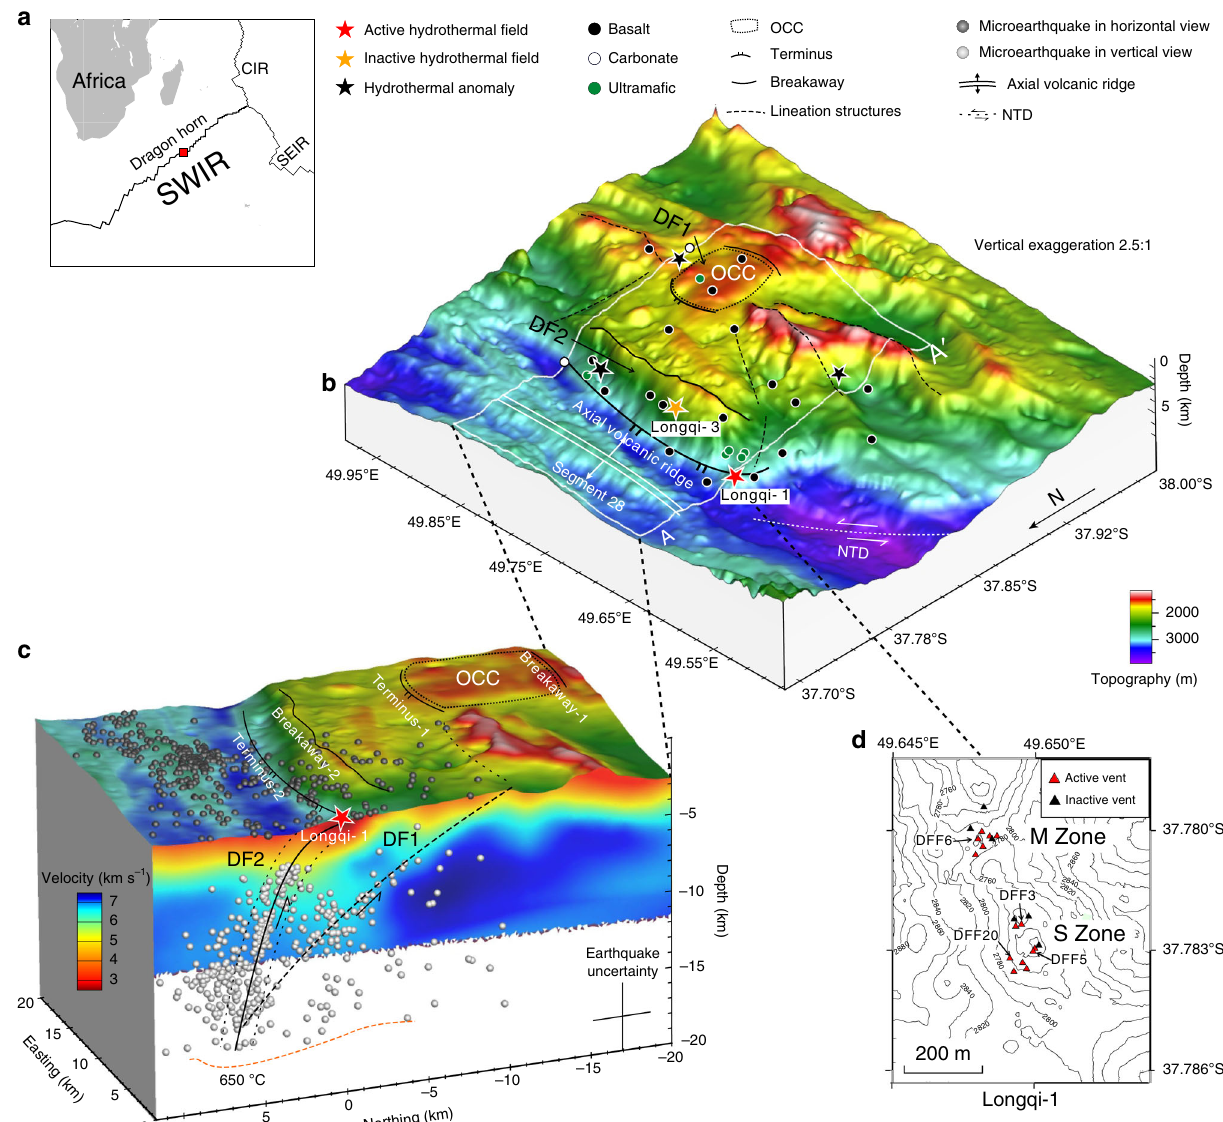
Fig. 1 Location and sketch of the Dragon Horn area. a Location of the Dragon Horn area at 49.7°E. b Bathymetry with tectonic and hydrothermal features. The corrugated surface of the OCC extends about 5 km × 5 km to the south in a series of steep scarps typical of breakaways, and to the north ending at the axial valley wall. NTD represent non-transform discontinuities. Location of hydrothermal fi elds and anomaly sites are shown as colored stars, including active Longqi-1 hydrothermal fi eld (red), inactive Longqi-3 fi eld (orange), and hydrothermal anomalies (black). c Three-dimensional view of the detachment fault zone. It shows the distribution of the epicenters, located within the white rectangle in Fig. 1b. The AA ′ seismic velocity pro fi le comes from a wide- angle seismic experiment 15 . d High-resolution bathymetry and distribution of vents in Longqi-1 fi eld. The bathymetry data were acquired by near-bottom underwater vehicles, human-occupied and autonomous underwater vehicles. DFF3, DFF5, DFF6, and DFF20 represent the vents from which the hydrothermal fl uids were sampled in this